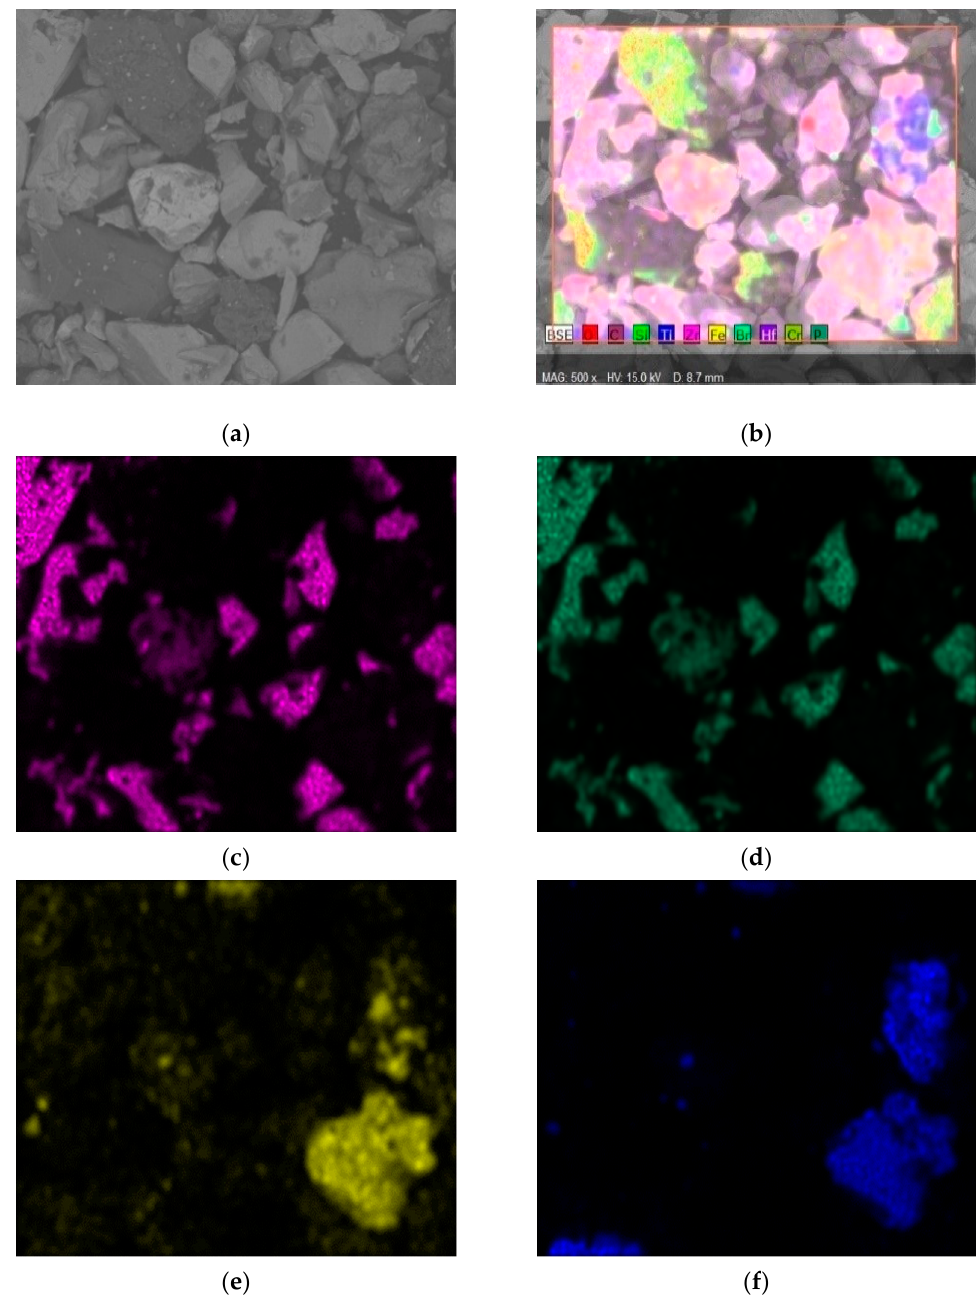
Figure 6. Distribution of the elements: ( a ) fraction 2; ( b ) distribution of elements on the surface; ( c ) zirconium; ( d ) phosphorus; ( e ) iron; ( f ) titanium.